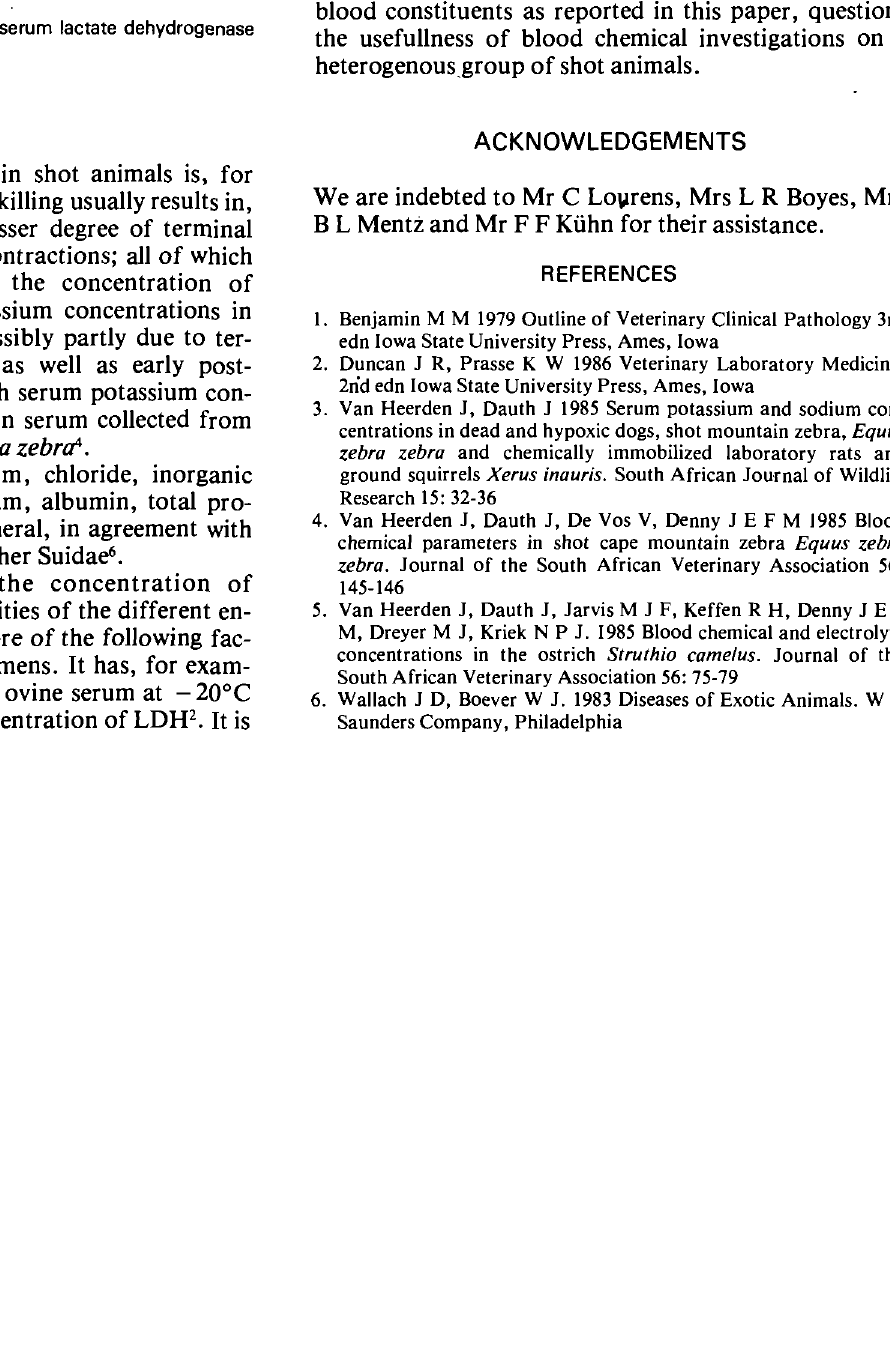
Fig. 17: The frequency distribution of serum lactate dehydrogenase (u (-1) n = 94 range = 189-2